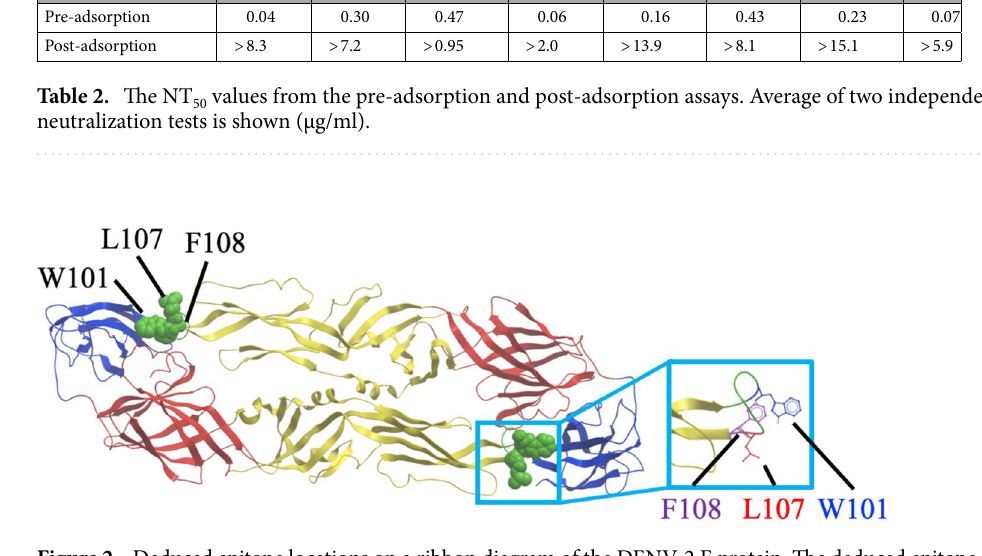
Figure 2. Deduced epitope locations on a ribbon diagram of the DENV-2 E protein. The deduced epitope locations were plotted on a DENV-2 E dimer, based on the data provided by the Protein Data Bank accession number 1OAN. DI, DII, and DIII are indicated in red, yellow, and blue, respectively. The fusion loop region (98–110) is colored in green. Mutations affecting reactivity with the HuMAbs are shown as green spheres and in the magnified square.